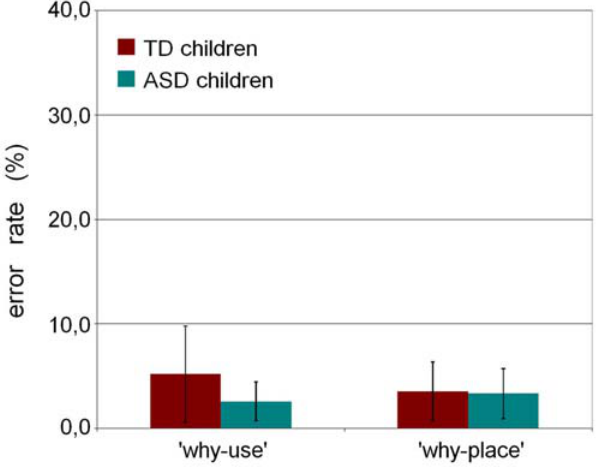
Figure 2. Results of Experiment 1. Error rates are plotted as percentage for each task. *** indicates significant difference (p=0.0001). Error bars represent 95% CI.